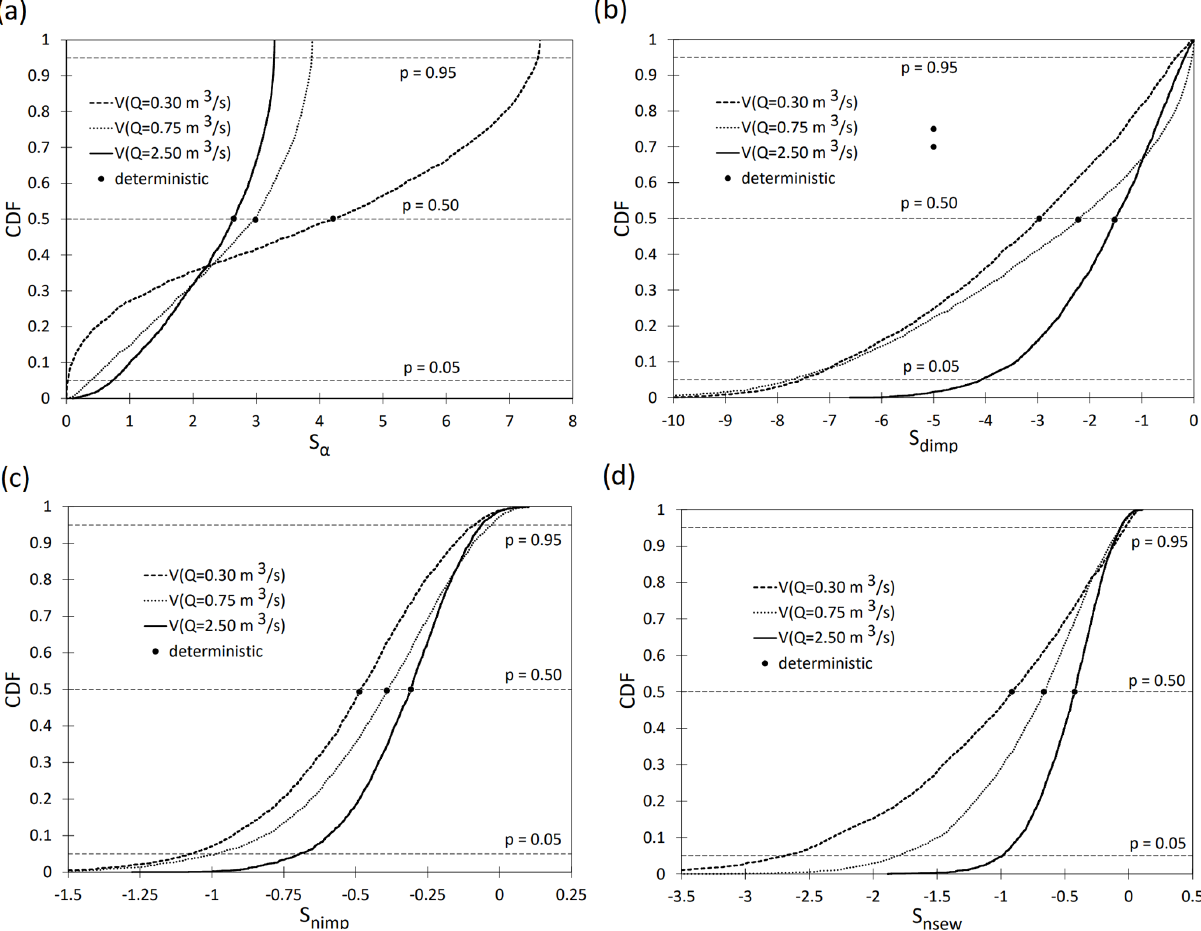
Figure 5. Comparison of the calculated results (deterministic and probabilistic solutions) of sensitivity coefficients ( S α , S dimp , S nimp , and S nsew ) for threshold values V (Q) = V g and temporal rainfall distribution ξ = R1, R2, and